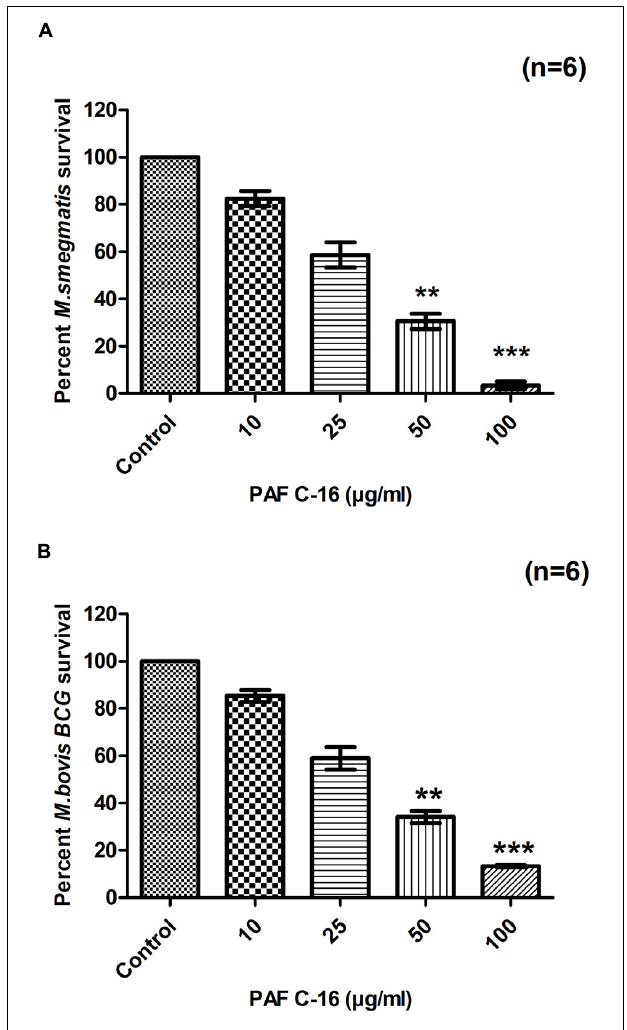
FIGURE 1 | Effect of PAF C-16 treatment on M. smegmatis and M. bovis BCG survival in vitro . Number of surviving colony forming units of M. smegmatis (A) and M. bovis BCG (B) after 2 h of treatment with the indicated concentrations of PAF C-16. Data is expressed in terms of percent survival where solvent control is taken as 100% survival and different PAF C-16 treated test conditions are compared to it. Each bar represents the average of six individual experiments performed in triplicate and the error bars show the standard error of mean values ( ± SEM). Statistically significant differences from the solvent control by Kruskal-Wallis test with post hoc Dunn’s multiple comparison test are indicated ∗∗ p ≤ 0.01, ∗∗∗ p ≤